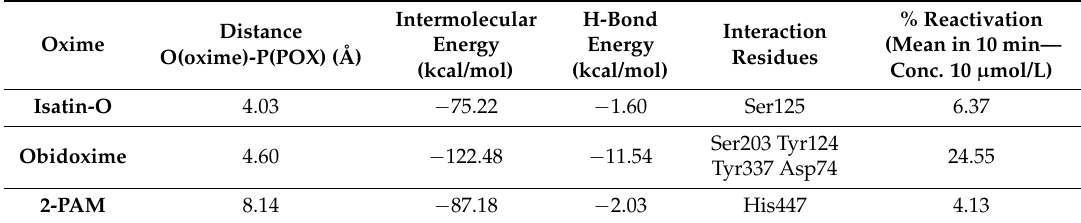
Table 1. Docking results for the oximes inside Ee AChE/POX.